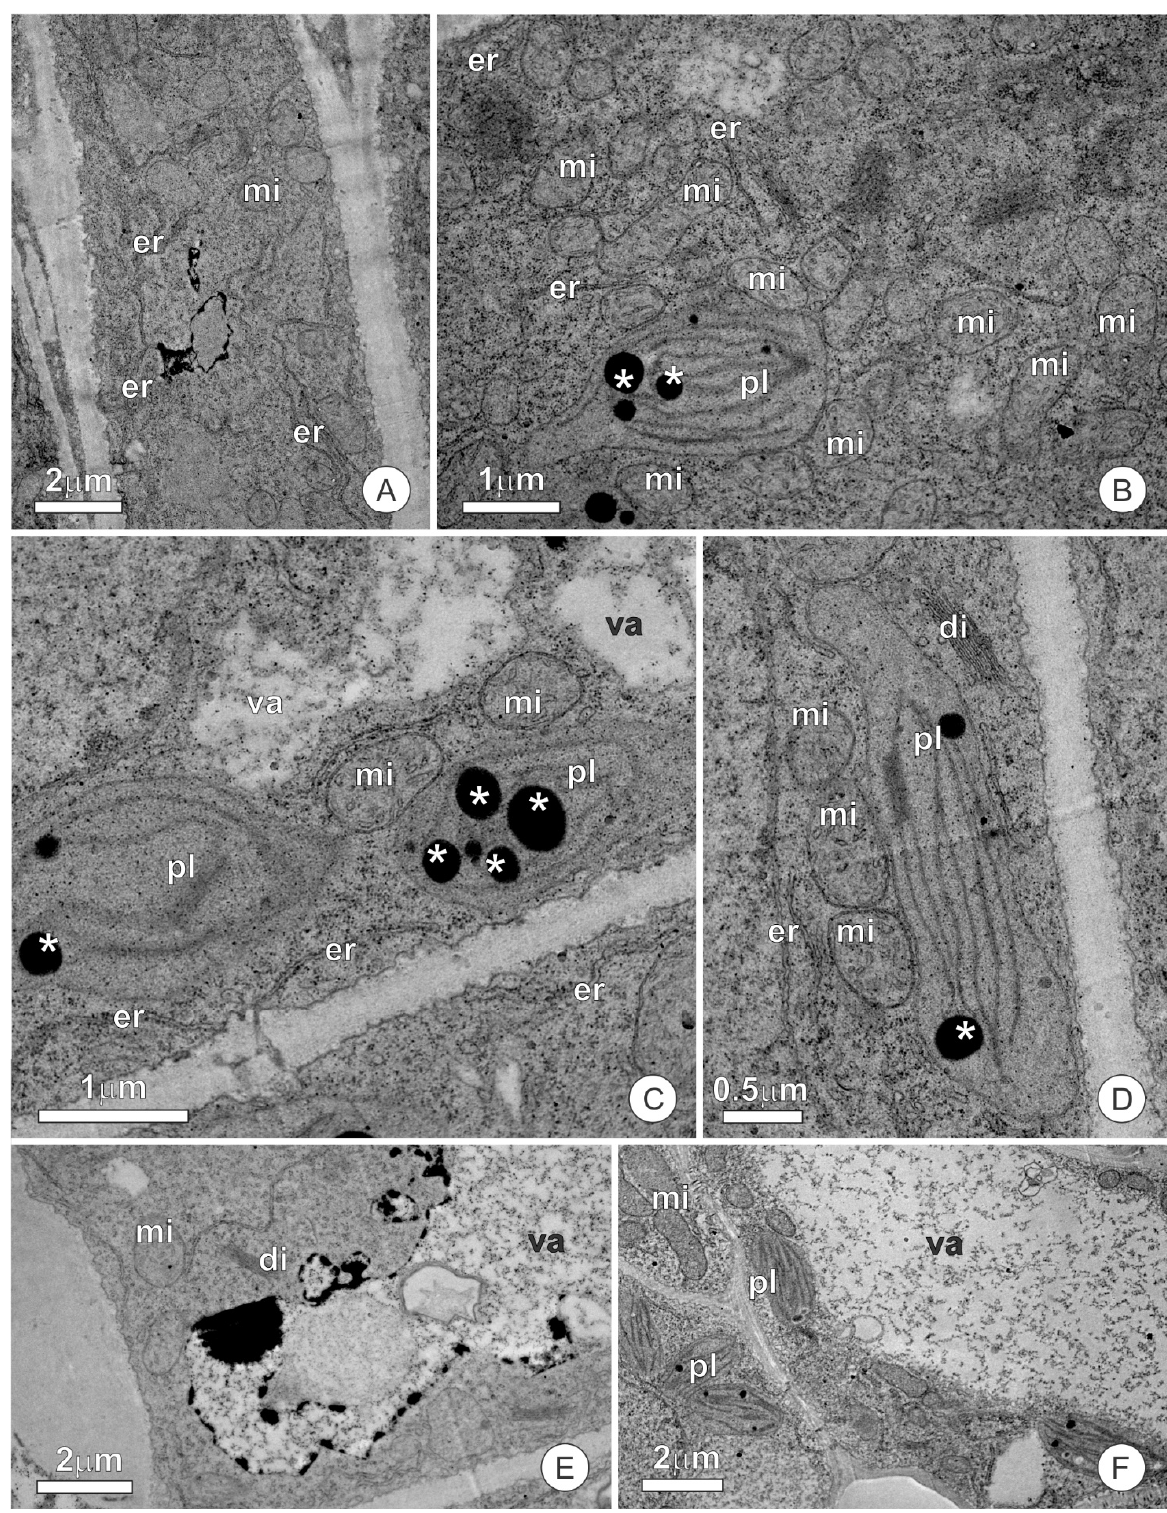
Figure 8. Ultrastructural aspects of the extrafloral nectaries of O. castaneifolia : ( A ) Overview of a secretory cell showing a dense protoplast; ( B – D ) Secretory cells showing organelle-rich cytoplasm with abundant mitochondria, segments of the rough endoplasmic reticulum, and plastids with a poorly developed inner membrane system. Note the numerous plastogobuli (*) dispersed in the stroma of the plastids and the small vacuoles filled with a flocculated content; ( E , F ) Cells of the subglandular parenchyma showing large vacuoles and extravacuolar cytoplasm rich in organelles. di = dictyosome, er = endoplasmic reticulum, mi = mitochondria, pl = plastid, va =